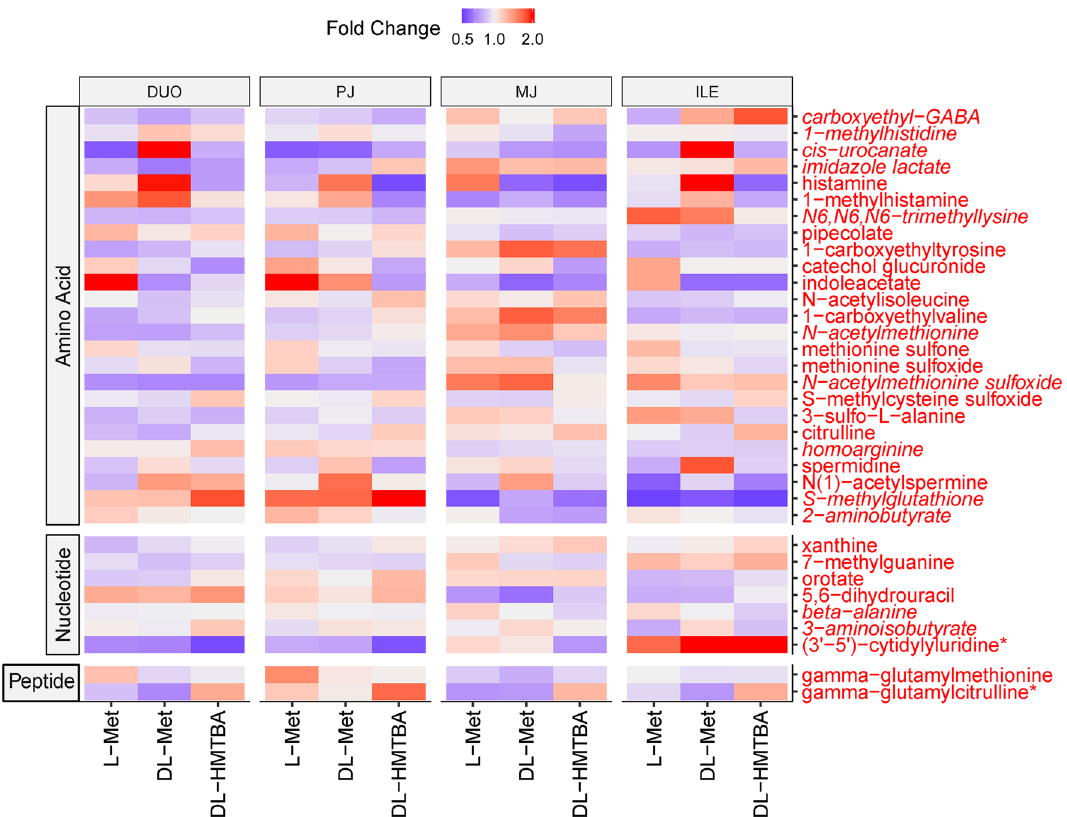
Figure 6. Heat map of individual metabolites from amino acid, nucleotide and peptide super-pathways that differed or tended to differ by treatment or region × treatment interaction ( P < 0.10), the latter depicted by italics font. Depicted is the metabolite distribution along duodenum (DUO), proximal jejunum (PJ), middle jejunum (MJ) and ileum (ILE) in pigs pre-fed with L-Met, DL-Met or DL-HMBTA. Blue color indicates lower abundance whereas red color indicates higher abundance of